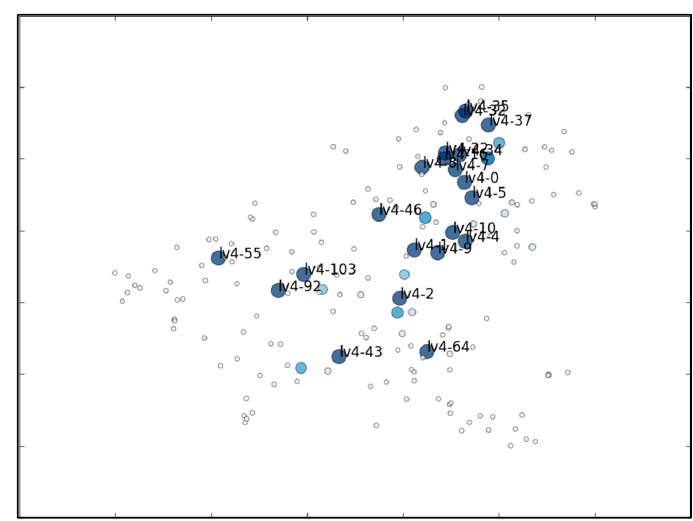
Figure 9. The extended circular dendrogram visualizing the hierarchy constructed from the Aerosol dataset.